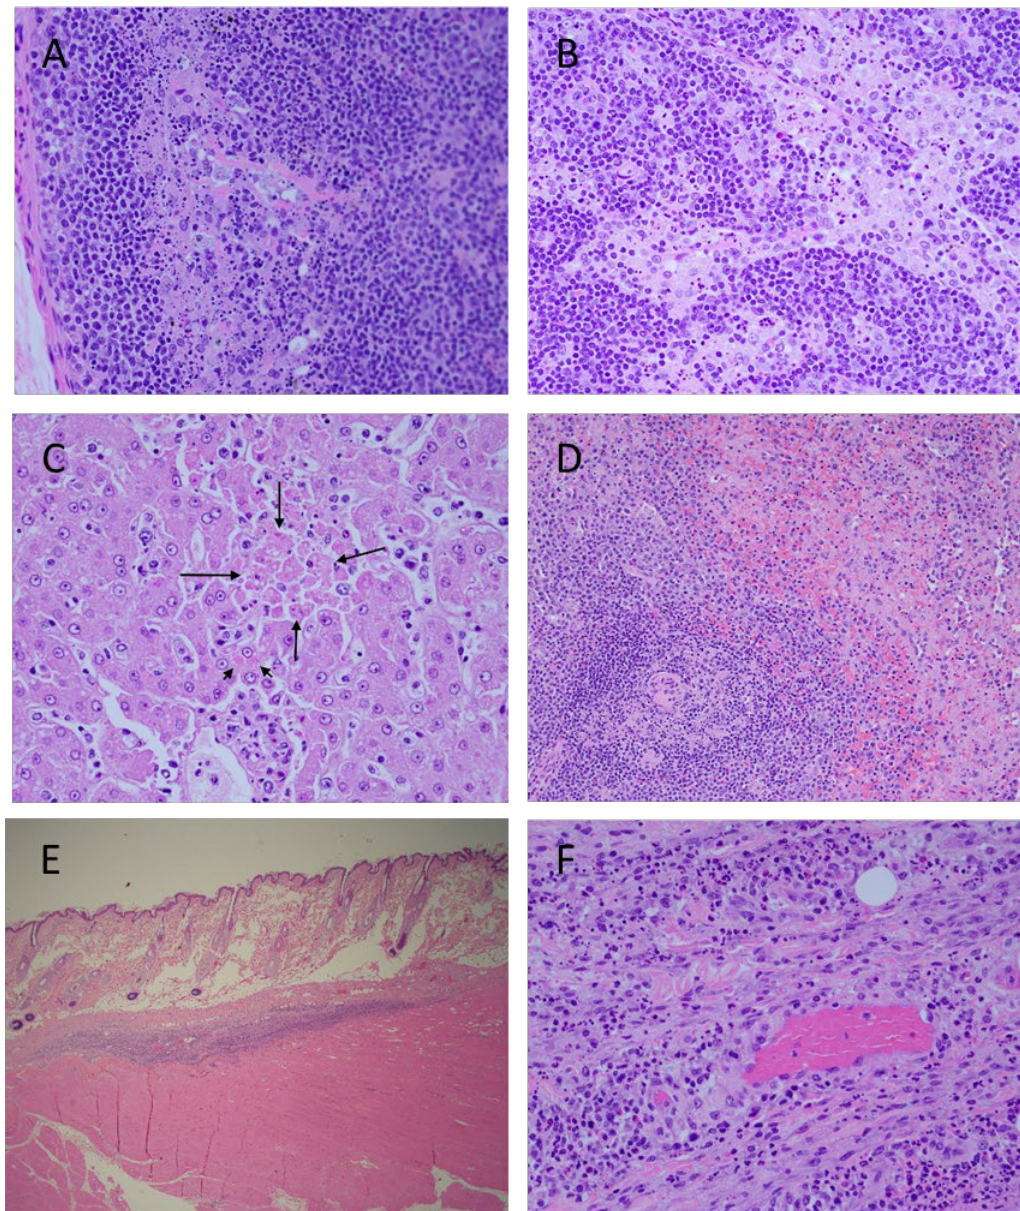
Figure 8. Histopathology Findings in MARV-exposed Cynomolgus Macaques. Cortex ( A ) and medulla ( B ), inguinal lymph node, extensive lymphocyte apoptosis. Liver ( C ), hepatocyte apoptosis (long arrows) and hepatocyte intracytoplasmic inclusion bodies (short arrow). Spleen ( D ), extensive lymphocyte apoptosis in white pulp and red pulp. Challenge site with mild inflammation ( E ). Higher magnification of challenge site ( F ), apoptosis of inflammatory lymphocytes. Photographs are representative.